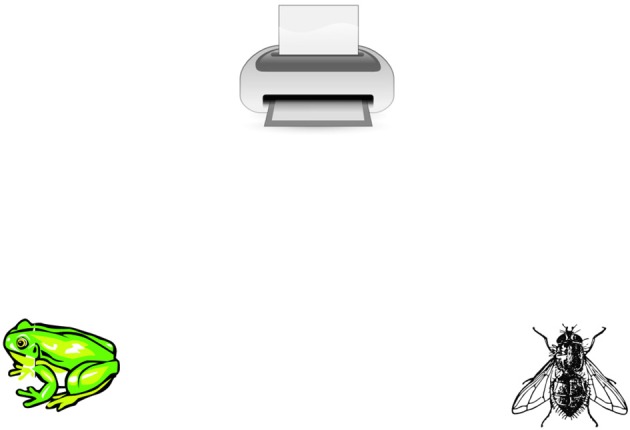
Example stimulus.